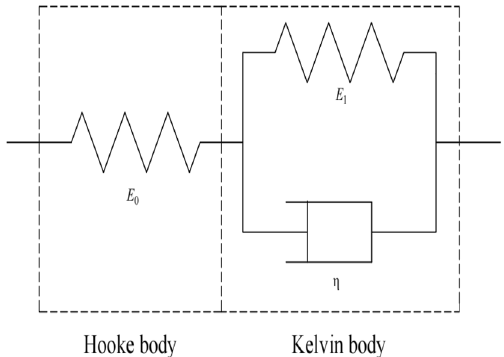
Figure 7. Generalized kelvin model.